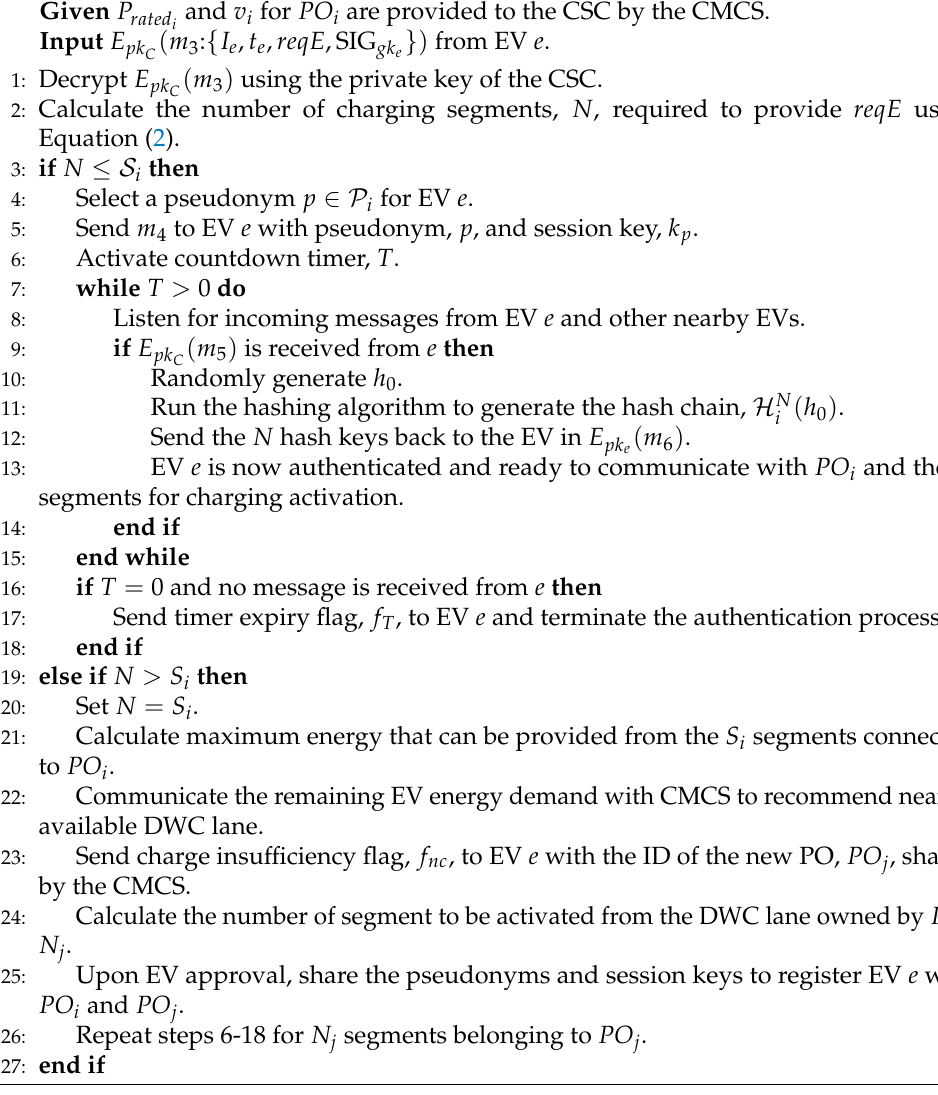
Algorithm 1 Proposed EV registration and authentication algorithm at the CSC. Given P rated and v i for PO i are provided to the CSC by the i